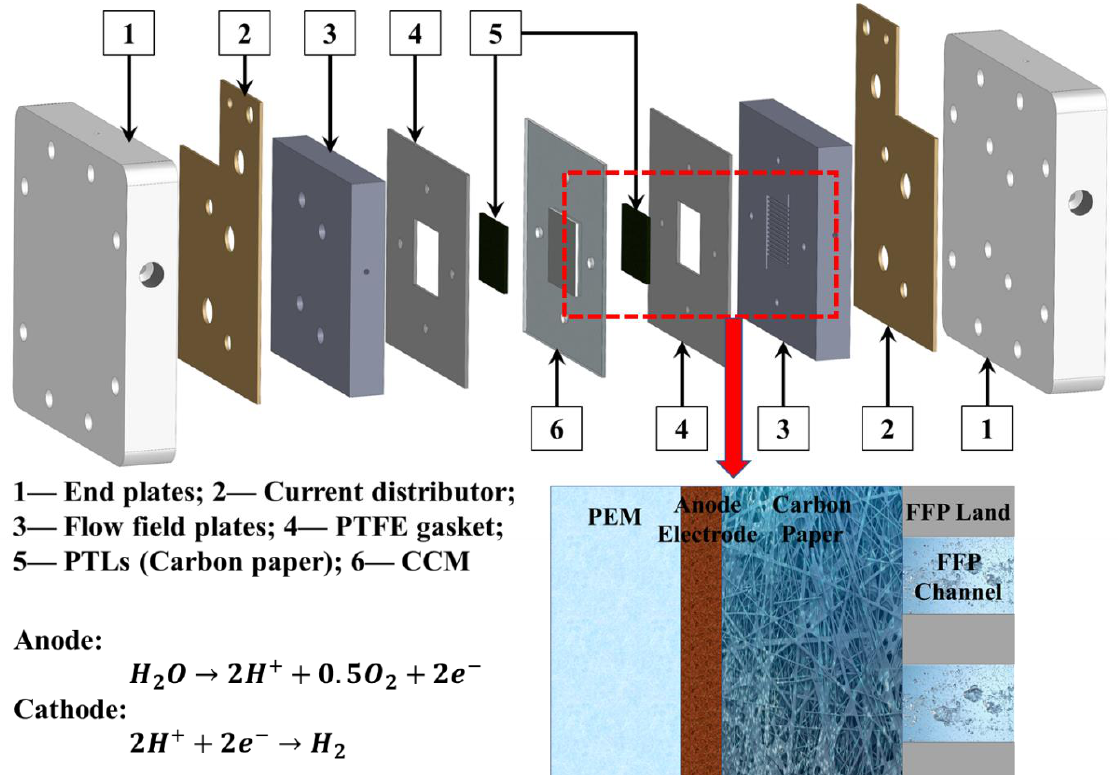
Figure 1. Schematic of typical PEMWE cells and components around anode